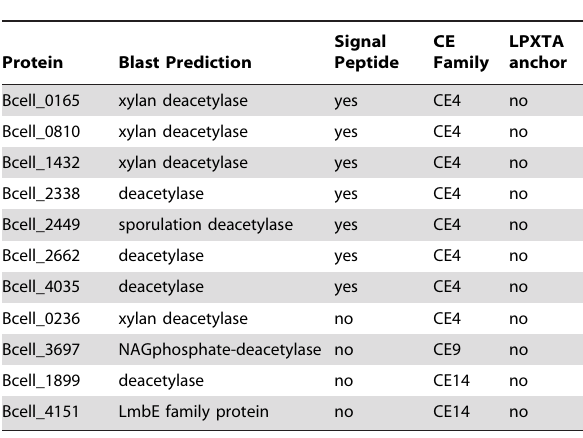
Table 6. Carbohydrate Esterases.